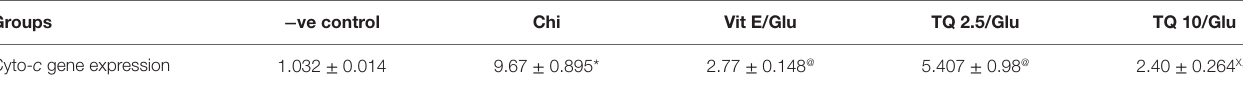
TaBle 4 | Effect of Glu, Vit E/Glu, TQ2.5/Glu, and TQ10/Glu on Cyto- c gene expression. groups